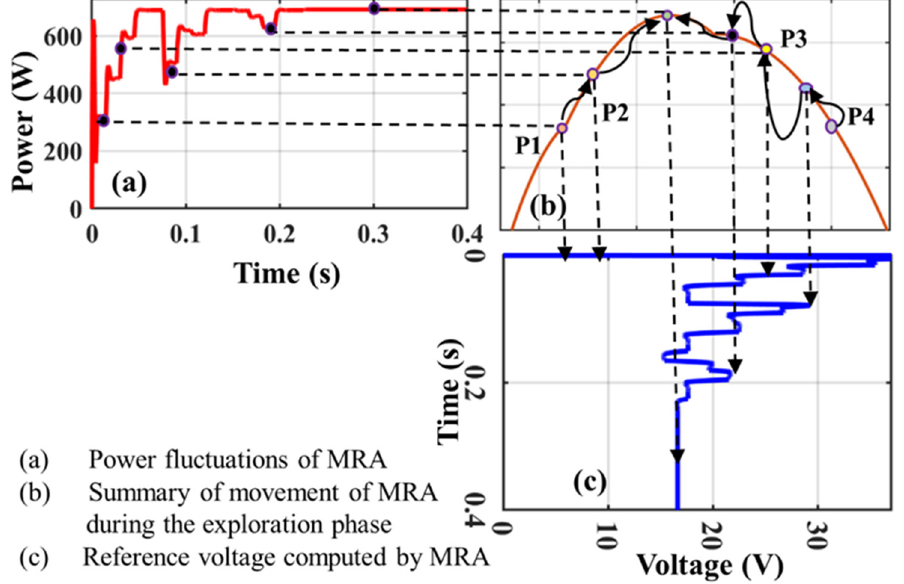
Figure 5. Tracking mechanism of MRA in TEG.